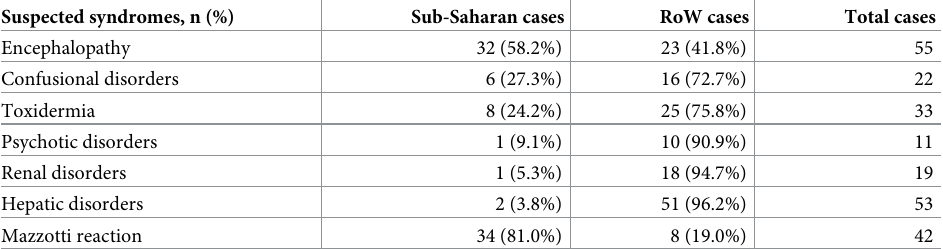
Table 5. Frequency of reported suspected syndromes by regions and in